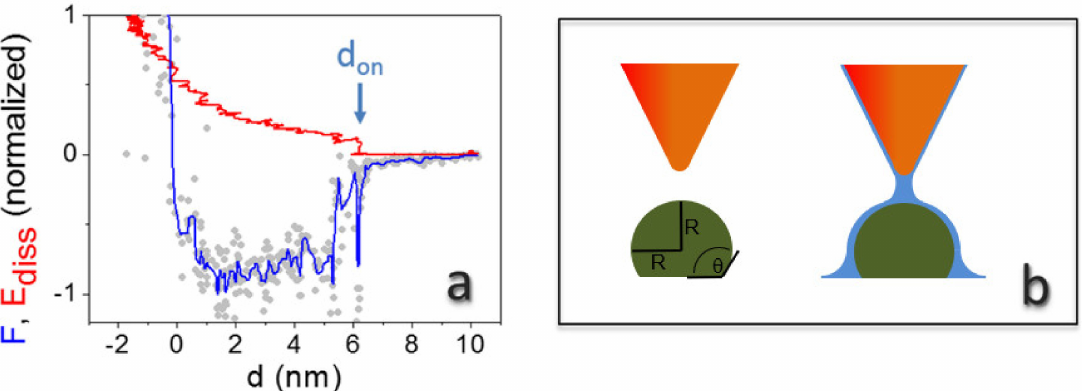
Figure 5. Typical reconstructed F curve (grey dots: raw data; blue line: data after smoothing) and E diss curve collected on top of an individual virion at RH > 100% (A 0 = 36 nm, F ad = 2.4 nN, E max = 257 eV) ( a ). Sketch of the tip of an atomic force microscope in the proximity of the surface of a virus in dry (left) and wet (right) conditions ( b ). The axial view shows also the water wedge at the interface virion/substrate; the curvature of the wedge is the inverse radius of TMV ( r − 1 = R − 1 = (9 nm) − 1